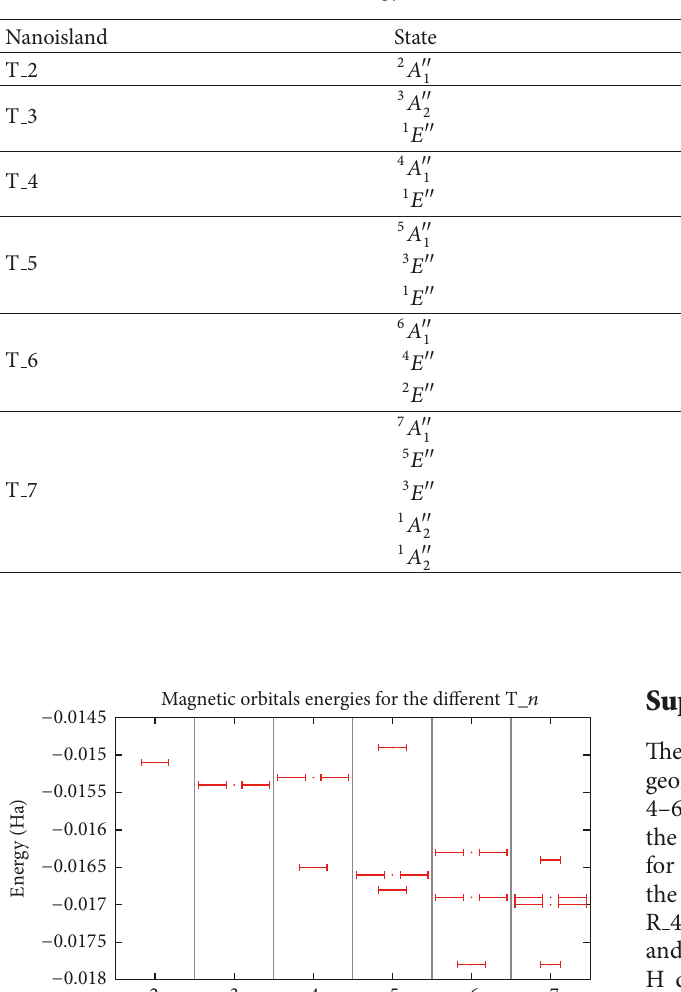
Table 11: Energy differences ( Δ𝐸 ) for the different triangle nanoislands in kcal/mol.